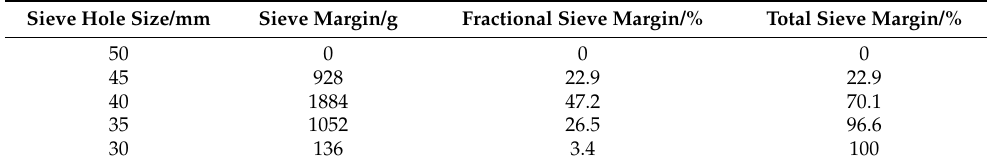
Table 2. Aggregate screening